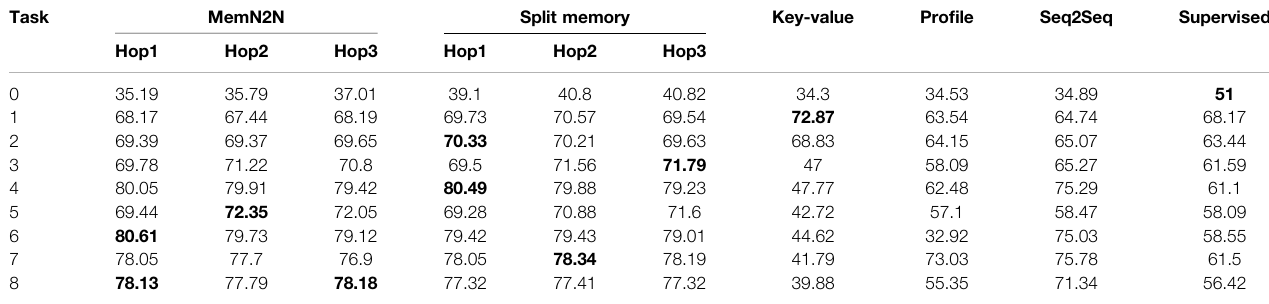
TABLE 9 | The test set results of the Personalised Barista Dataset with 10,000 dialogues. The best performing methods (or methods within 0.1% of best performing) are given in bold for the per-response accuracy metric. The results show that on average, Split Memory is the best performing model, however, End-to-End Memory Network (MemN2N) is the best model for task 8 (containing all tasks).